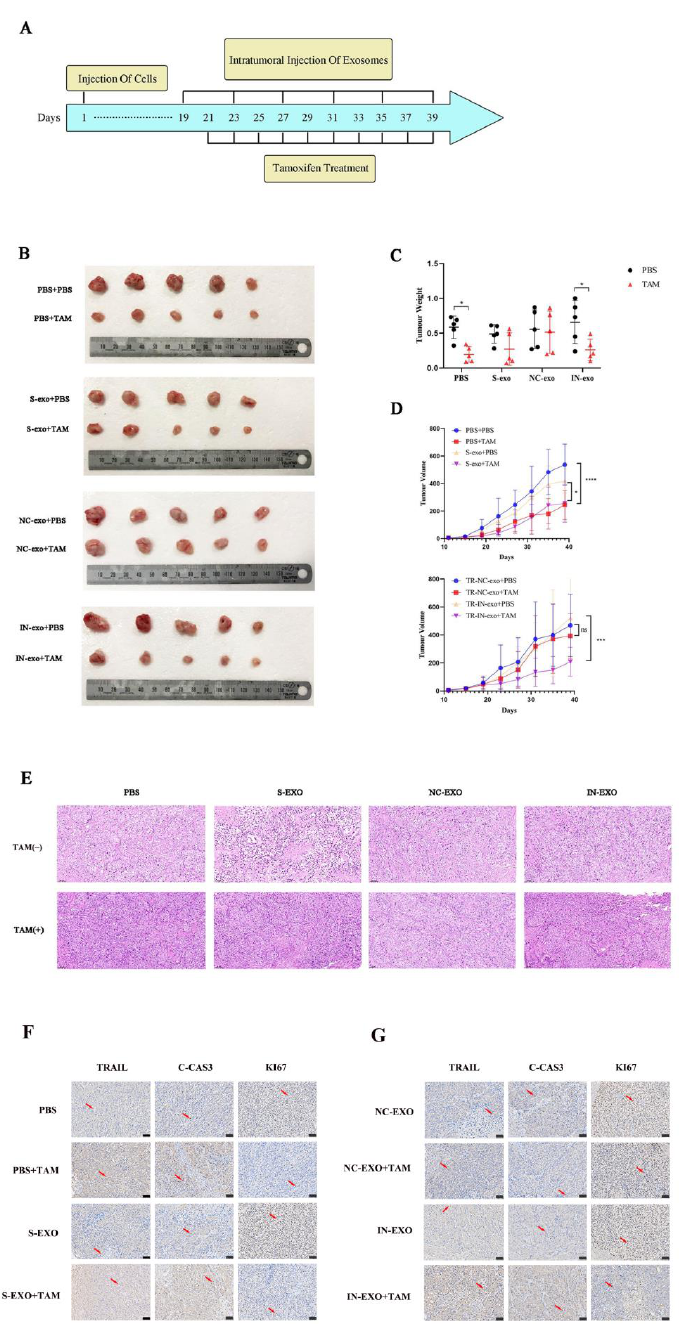
Figure 6. Exosomal tRF-16-K8J7K1B promote tamoxifen resistance in vivo. ( A ) Schematic diagram of animal experiment. ( B ) After exosomes and tamoxifen treatment, tumors isolated from mice are shown in images. ( C ) Tumor weight at the endpoint. ( D ) Tumor volume changes during our study. ( E ) Tumor tissue slices were stained with hematoxylin-eosin. ( F , G ) Immunohistochemistry analyses of the expression of TRAIL, cleaved caspase 3, and Ki67 in tumor tissues. The red arrows indicate the positive immunohistochemical reactions. S-exo: exosomes derived from tamoxifen-sensitive cells; NC-exo: exosomes derived from tamoxifen-resistant cells transfected with tRF-16-K8J7K1B NC; IN-exo: exosomes derived from tamoxifen-resistant cells transfected with tRF-16-K8J7K1B inhibitor; C-CAS3: cleaved caspase 3. Scale bars: 50 µ m. Data are presented as mean ± SEM. * p < 0.05; *** p < 0.001; **** p < 0.001; ns: no